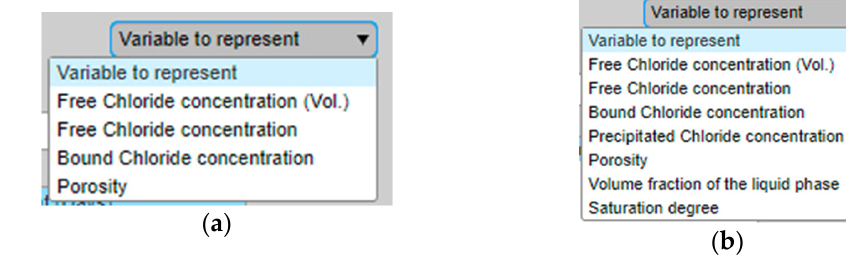
Figure 14. Variables to be shown. ( a ) saturated, ( b ) unsaturated.